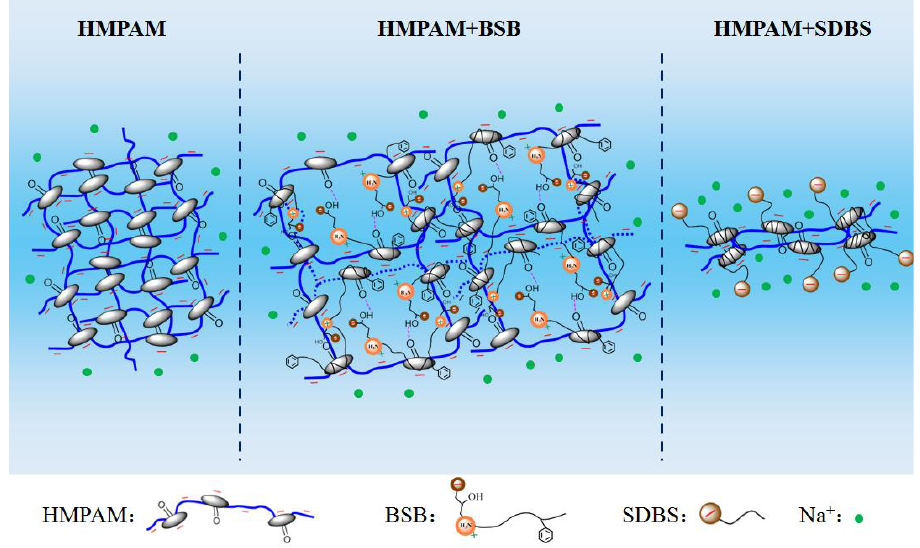
Figure 6. Schematic diagram of the mechanism for the effect of BSB and SDBS on the viscosity of the HMPAM solution.